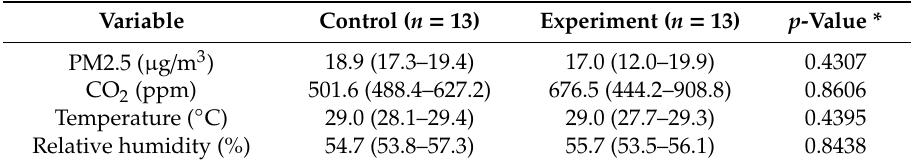
Table 2. Summary (median interquartile range, IQR) of baseline indoor air-quality information.